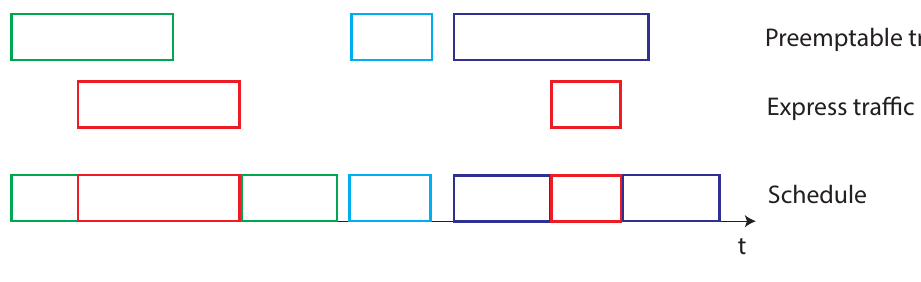
Figure 10. Express and preemptable traffic: an